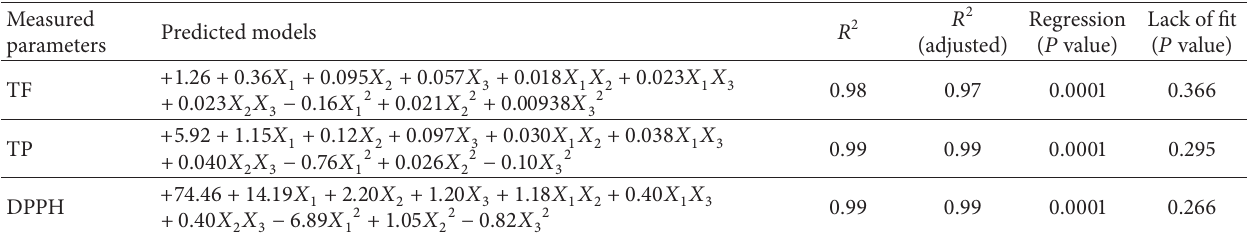
Table 3: Predicted models and statistical parameters calculated after implementation of three-factor central composite